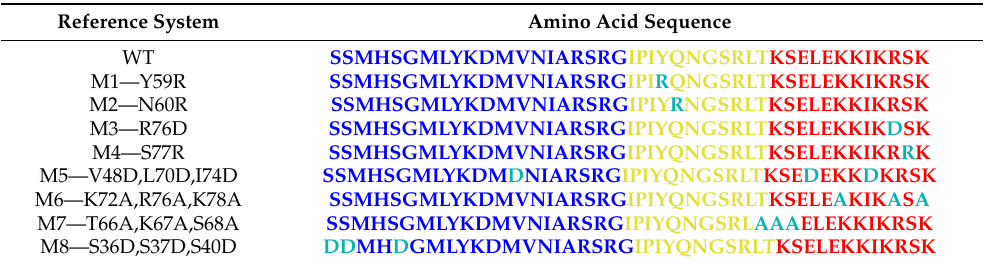
Table 1. The 43 a.a. p10 mutant systems simulated in this work. The sequence of each mutant is colored according to the previously defined color code. Mutated residues are highlighted in cyan.